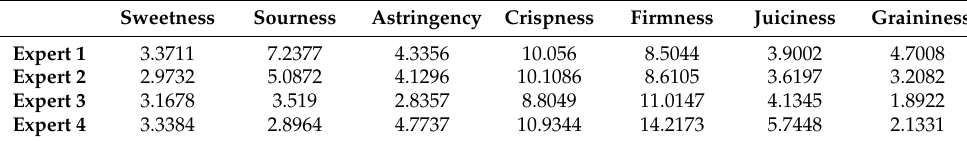
Table 8. Discrimination power of experts as assessed by the F ratio of the F test.